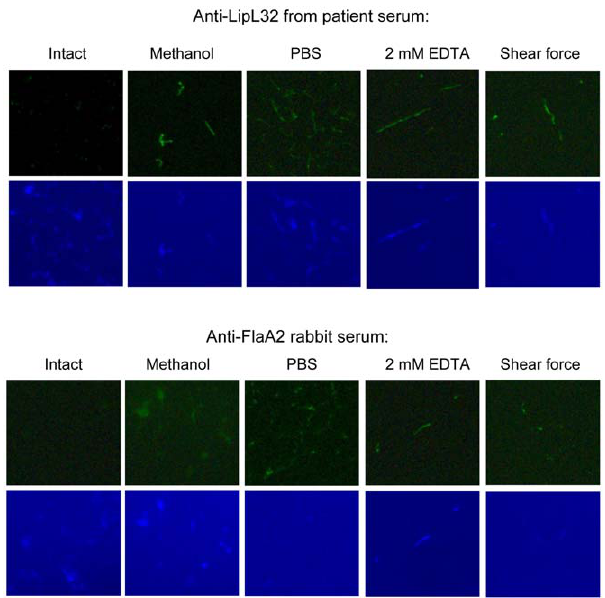
Figure 4. Confirmation of subsurface locale of LipL32 by surface IFA and various outer-membrane permeabilization methods. Intact spirochetes or cells disrupted by methanol, vortexing and high-speed centrifugation, 2 mM EDTA or shear force were probed with affinity purified LipL32 antibodies from leptospirosis patient sera or FlaA2 rabbit serum as a control. The data is representation of three experiments performed separately. Binding of antibodies to leptospires were detected either with Alexa Fluor 488 conjugated goat anti-human IgG fragments (for LipL32) or Alexa Fluor 488 conjugated goat anti- rabbit IgG fragments (for FlaA2). A DAPI counterstain was used to demonstrate the presence of spirochetes. The identities of individual proteins recognized by the particular antibody reagent are indicated on the top of each column.